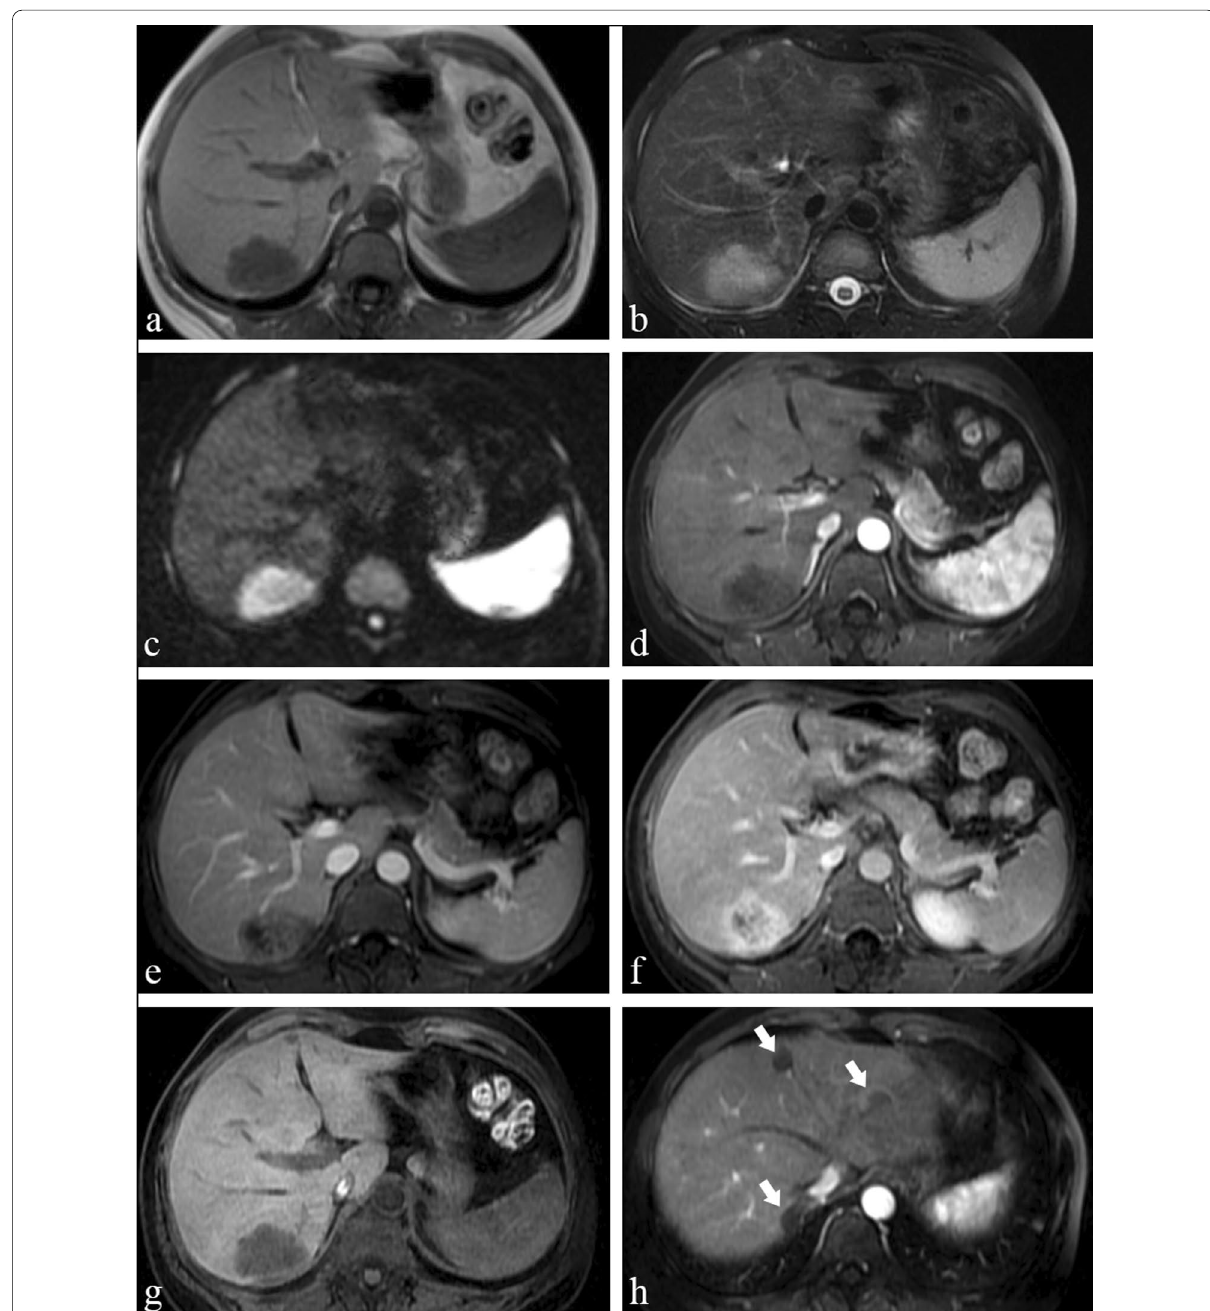
Fig. 5 A 36-year-old female with pathologically diagnosed HEHE. Axial unenhanced T1-weighted MRI ( a ) demonstrates a hypointense tumour in segment 6 of the liver, which is hyperintense on axial fat-suppressed T2WI ( b ) and DWI ( c ). On contrast-enhanced images of three phases ( d , f ), the tumour presented enhancement pattern A, with peripheral irregular enhancement on arterial phase ( d ), with centripetal progressive filling on the portal venous phase and ( e ) equilibrium phase ( f ) along with gradually increasing intensification, and a “lollipop sign” can be seen on portal venous phase. The tumour manifested as a homogeneous hypo-intensity on the HBP ( g ). There were other lesions (arrows) in the upper part of the liver on the arterial phase ( h ) with pathologically proven epithelioid